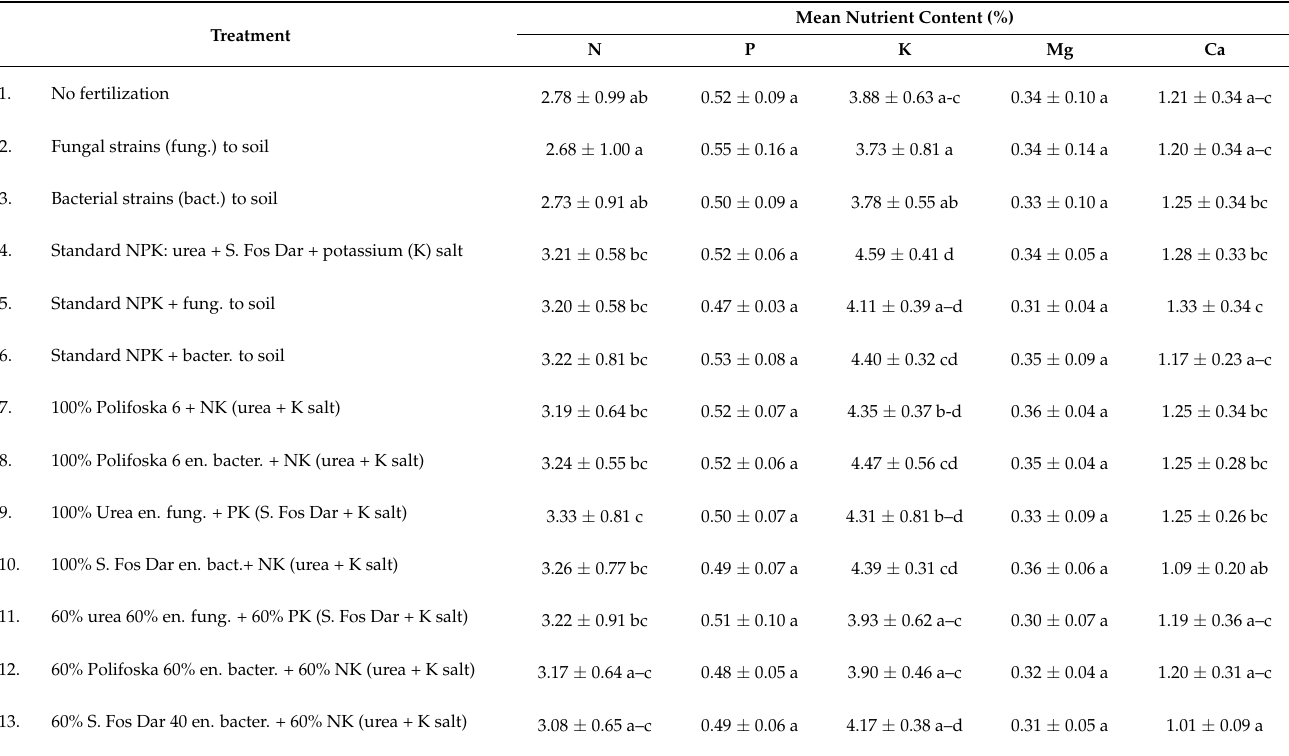
Table 5. Mean macronutrient content in weed shoots in the apple orchard,